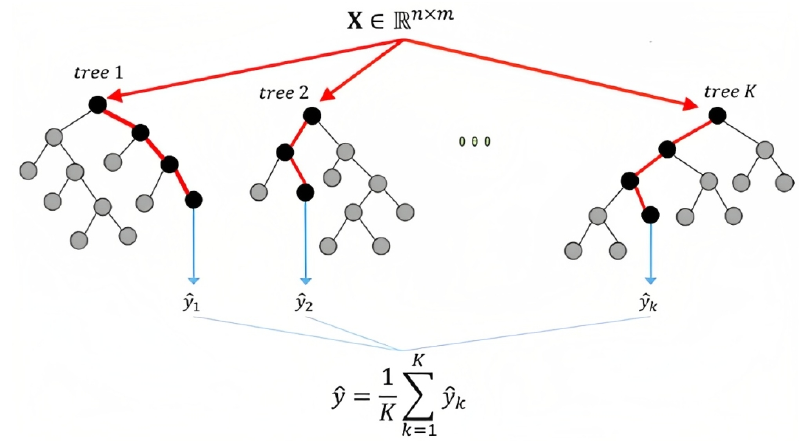
Figure 2. Random Forest’s structure. Adapted from ref